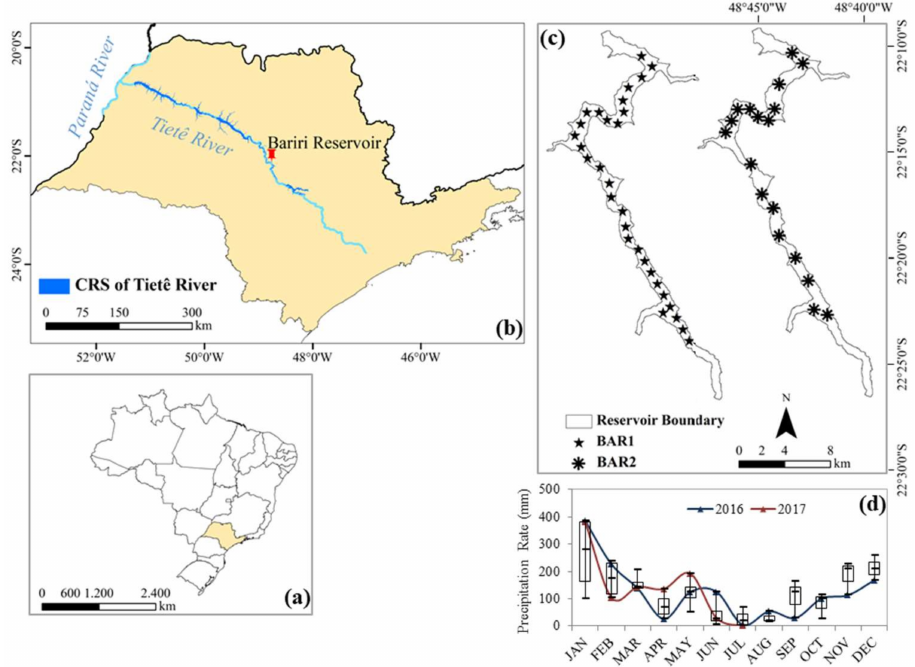
Figure 1. Graphics showing the location of ( a ) S ã o Paulo State in the Brazilian context; ( b ) the Bariri Reservoir in the Cascading Reservoir System of the Tiet ê River; ( c ) sampling points of the two field campaigns carried out, BAR1 and BAR2; and ( d ) precipitation rate data (mm) from NASA’s GIOVANNI database for the period of 2014–2017 with the years of 2016 and 2017 highlighted (TRMM Data Product; Spatial Resolution of 0.25 ◦ ; Monthly Temporal Resolution). In 2017, the precipitation monthly averages were available just until the month of